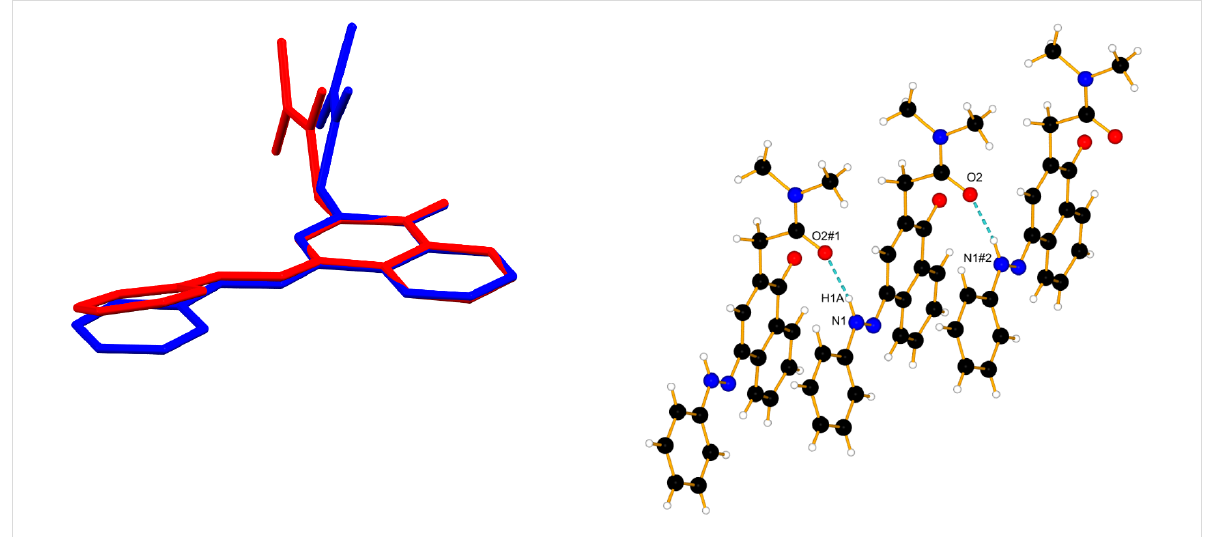
Figure 3: Left: Theoretically predicted structure of 6K (blue), overlaid with the X-ray structure (red). Right: X-ray structure of 6 , #1: x − 1, y, z; #2: x + 1, y, z; H bonds are drawn as blue dashed lines.